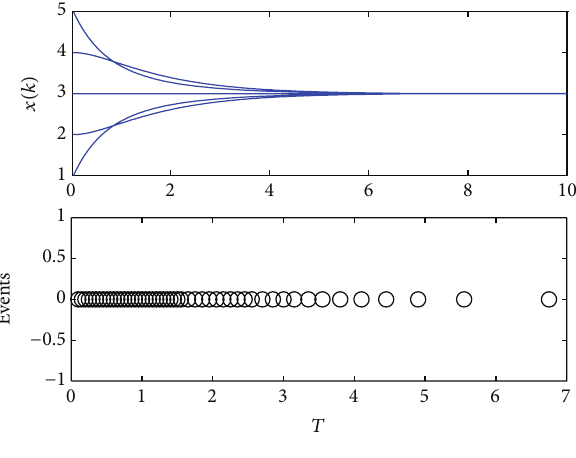
Figure 4: Protocol (4) for 𝑝 = 0.9 .